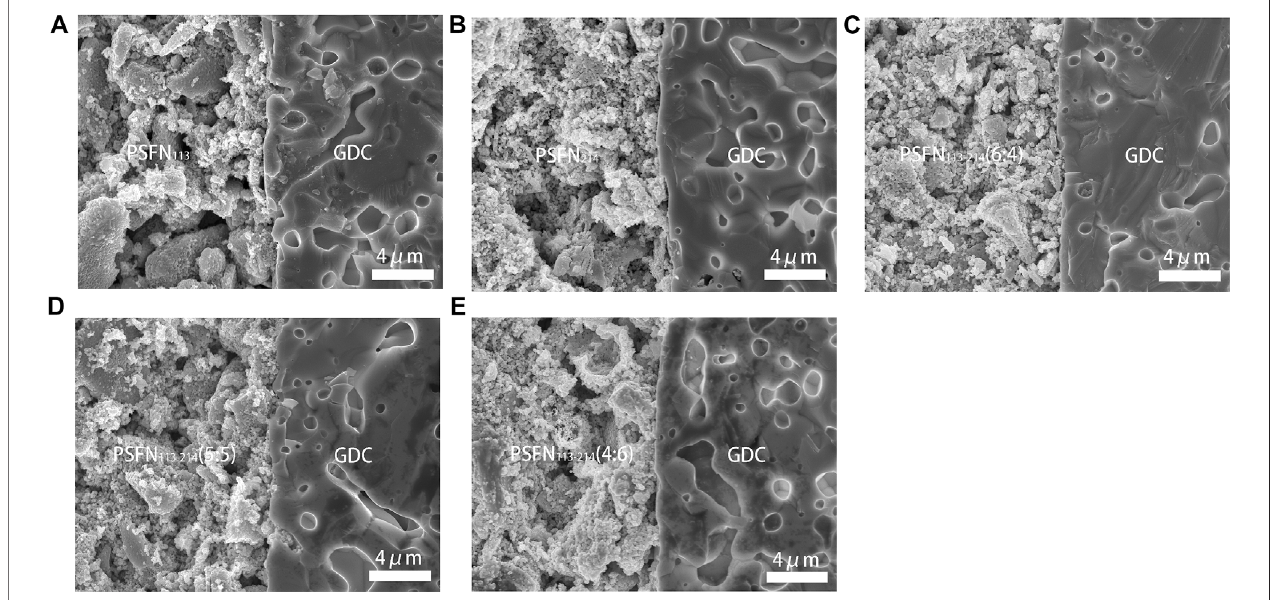
FIGURE7| AftertheEIS test, thecross-sectionalSEMofthesymmetricalcellwith (A) PSFN 113 , (B) PSFN 214 , (C) PSFN 113-214 (6:4), (D) PSFN 113-214 (5:5), and (E) PSFN 113-214 (4:6) as the